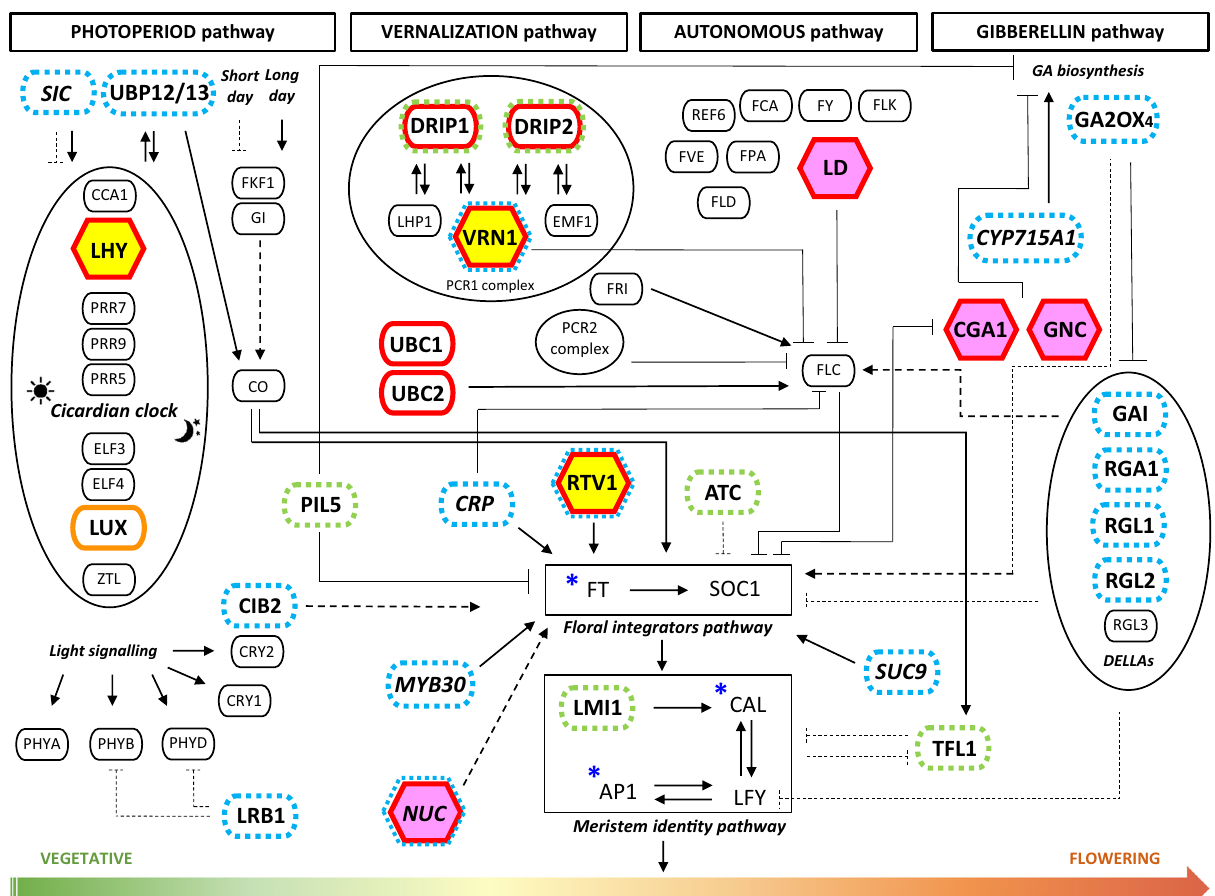
Fig. 5 | Candidate genes for adaptation. Schematic representation of the reg- ulatory networks underlying the four major fl owering pathways in Arabidopsis thaliana . The genes involved in the photoperiod, vernalisation, autonomous and gibberellin pathways that lead to the transition from vegetative to fl owering are shownbelowthecorrespondingpathway.Additionalgenesbelongingtosecondary pathways that interact with the main regulatory fl owering networks are shown in italic. Orthologues genes in common bean showing signatures of adaptive intro- gression, and those located in GWA peaks in our study are highlighted as follows: yellow hexagons – common bean orthologues of LHY ( Phvul.009G259400 , Phvul.009G259650 )and VRN1 and RTV1 ( Phvul.011G050600 )showingprivateinter- chromosomal linkage disequilibrium (LD) in the EU_M pool; pink hexagons – common beanorthologues of LD ( Phvul.001G204600 ), NUC ( Phvul.001G204700 ), CGA1 and GNC ( Phvul.003G137100 ) showing private inter-chromosomal LD in the EU_M pool; red outlines – atleast one orthologous gene in common beanshowing signature of selection, introgression and with a signi fi cant differentiation ( F ST index) between American and Europeanaccessions ( p <0.05); orange outlines –